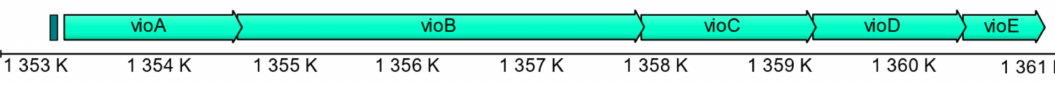
Figure 2. Diagram of the violacein production loci in the Janthinobacterium sp. SLB01 genome. Genes are displayed with arrows. A conserved sequence motif within the promoter region is displayed with the gray bar.